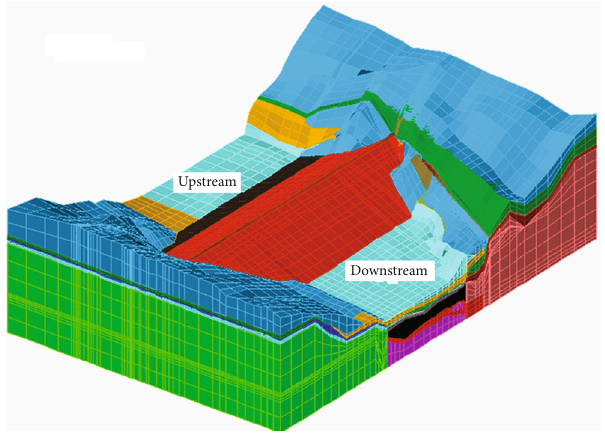
Figure 3: Three-dimensional fi nite element model of a hydro- junction